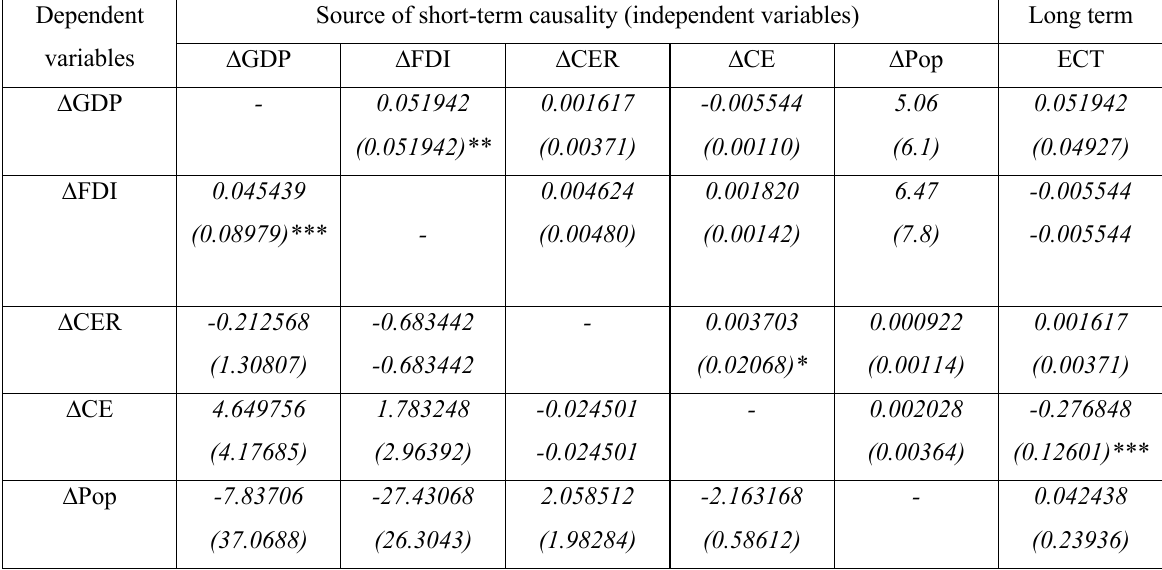
Table 4. The Panel VECM Granger Casuality